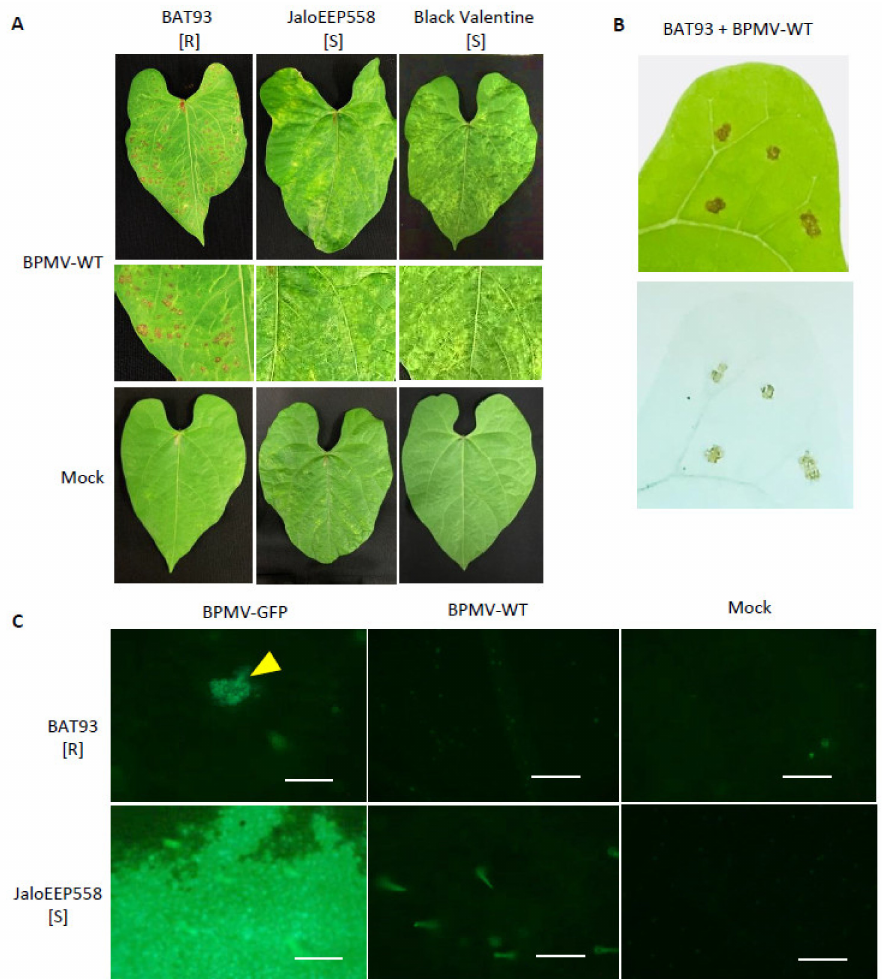
Figure 1. BPMV is able to multiply and move from cell-to-cell in the inoculated leaves of genotype BAT93 at 20 ◦ C but infection is finally restricted by the induction of local Hypersensitive-Response (HR) lesions: ( A ) Representative pictures of local HR lesions on six BAT93-inoculated leaves of six different plants grown at 20 ◦ C, 7 days post-inoculation (dpi) with BPMV-WT. JaloEEP558 and Black Valentine were used as susceptible control genotypes on which mosaic/mottling symptoms are visible on the inoculated leaves at 7 dpi with BPMV-WT. Mock was used as control. This experiment was performed at least 3 times with similar results. ( B ) Local HR lesions (top) and lesions visualized using trypan blue staining (bottom) on BAT93 leaves inoculated with BPMV-WT at 20 ◦ C. Pictures were taken at 7 dpi. ( C ) Microscopic observations of GFP fluorescence in six inoculated leaves of six different plants of either BAT93 or JaloEEP558, both grown at 20 ◦ C. Observations were made at 4 dpi. The BPMV-GFP construct expressing GFP as an individual protein processed from the RNA2 polyprotein was used as a reporter of BPMV infection. BPMV-WT and Mock were used as control. Yellow triangle indicates GFP foci. Autofluorescence is visible with BPMV-WT and Mock assays. All infection assays were made at 20 ◦ C. Scale bars = 250 µ